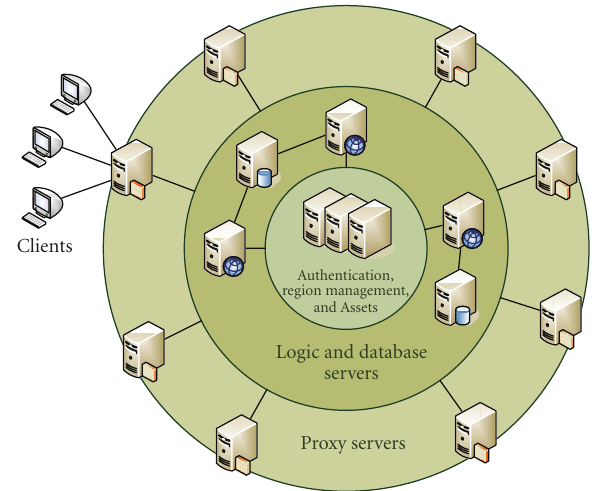
Figure 1: Conceptual overview of